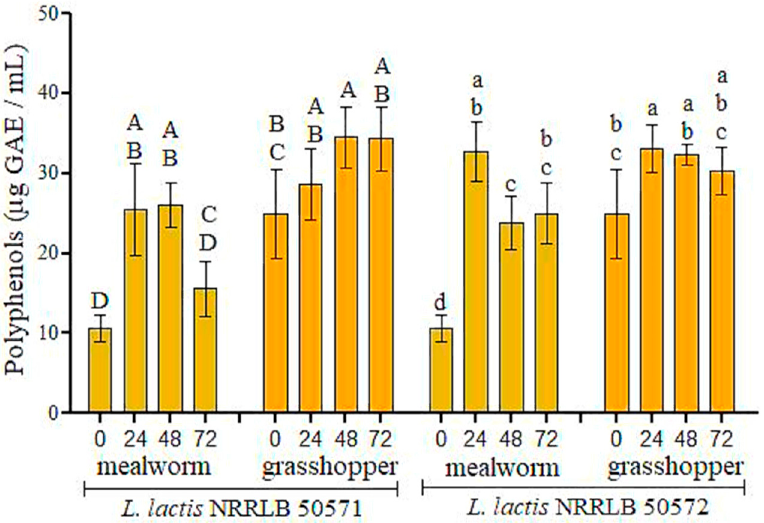
Figure 1. The total polyphenol contents of the <3 kDa fractions obtained from the two fermented edible insect flours. The values show the mean ± standard deviation ( n = 3). Upper case letters (A–D) show significant differences ( p < 0.05) among insects fermented for L. lactis NRRL B-50571, and